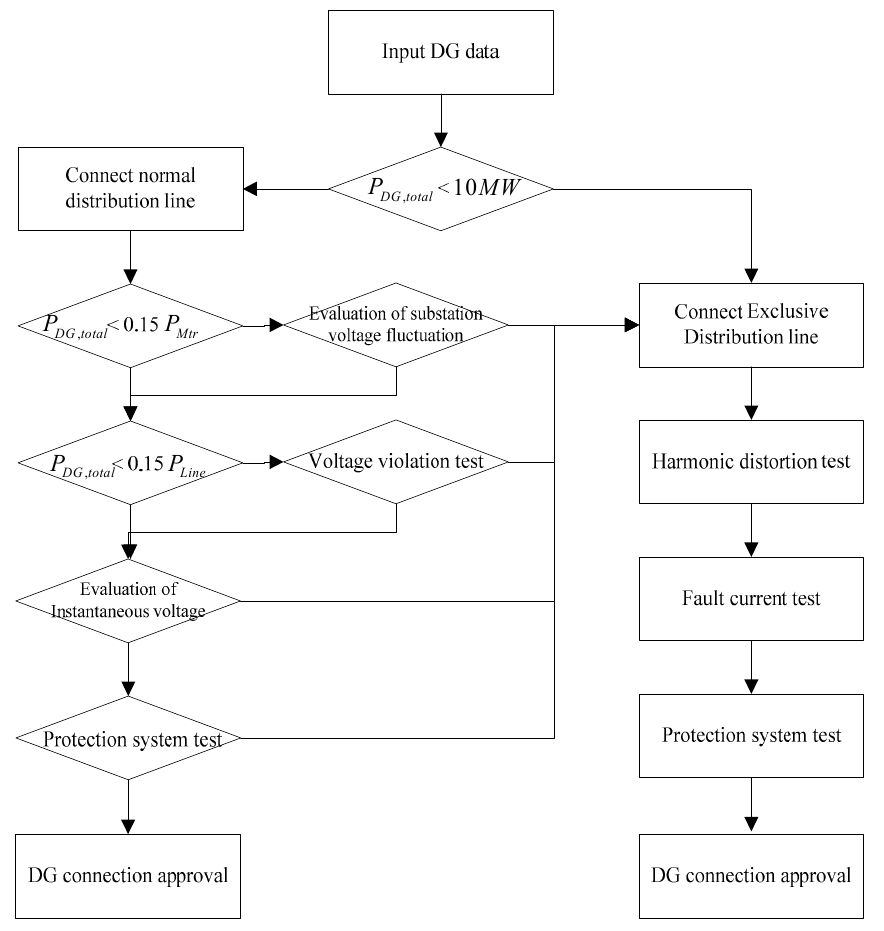
Figure 5. Algorithm for preliminary evaluation of DG connection.